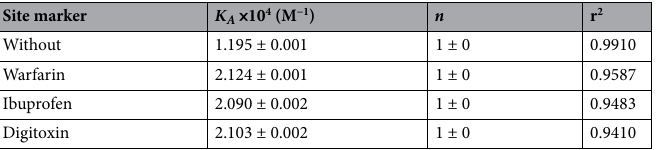
Table 4. Binding constant ( K A ) and number of binding site ( n ) of 5A8HQ to BSA (4 µM) in the presence and the absence of site markers (4 µM) at 310 K. r 2 is the squared correlation